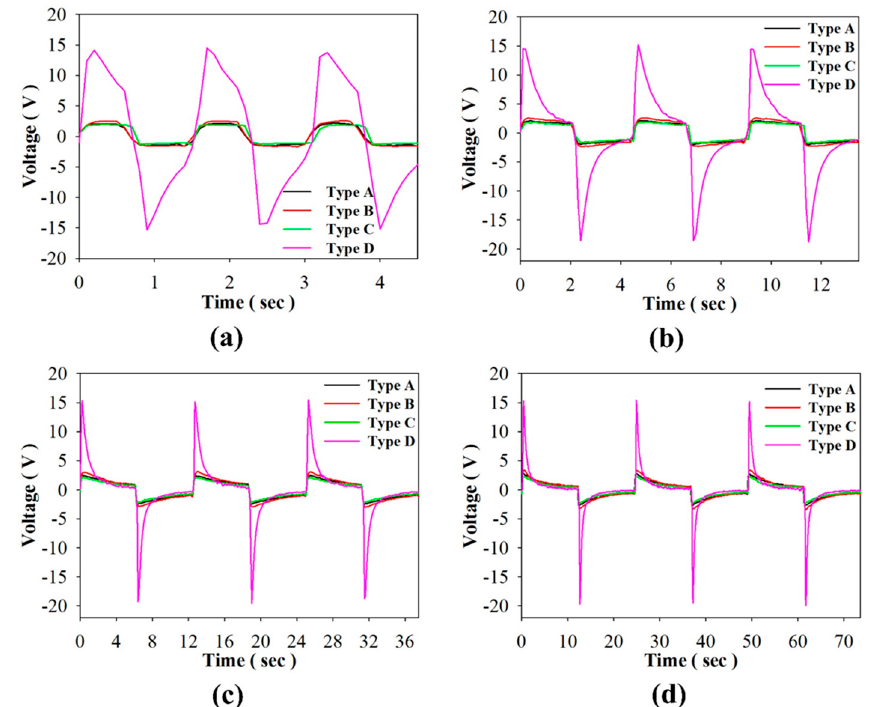
Figure 10. Relationship between the induced voltage and time for using the PZT cell with various structures (Types A to D) and periods of about ( a ) 1 s; ( b ) 4 s; ( c ) 12 s; and ( d ) 24 s.